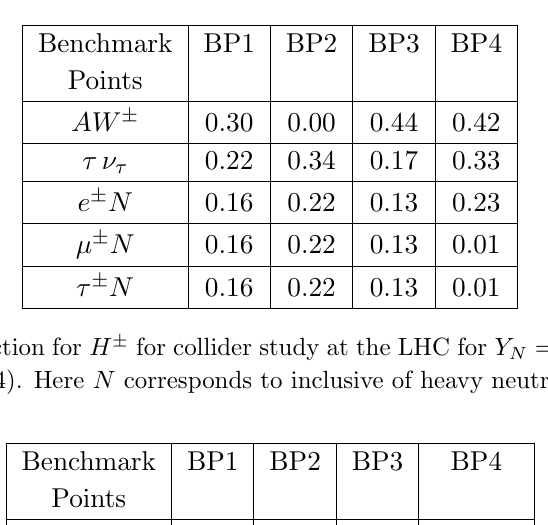
Table 1 . Benchmark points for a collider study consistent with m h (cid:24) 125 GeV the SM like Higgs mass and with the 2 (cid:27) limits of h ! WW (cid:3) ; ZZ (cid:3) ; (cid:13)(cid:13) [35]. Here we have only considered the non-zero diagonal Yukawa couplings i.e., Y N (cid:17) Y N , respectively. 1 ; 2 ; 3 11 ; 22 ; 33